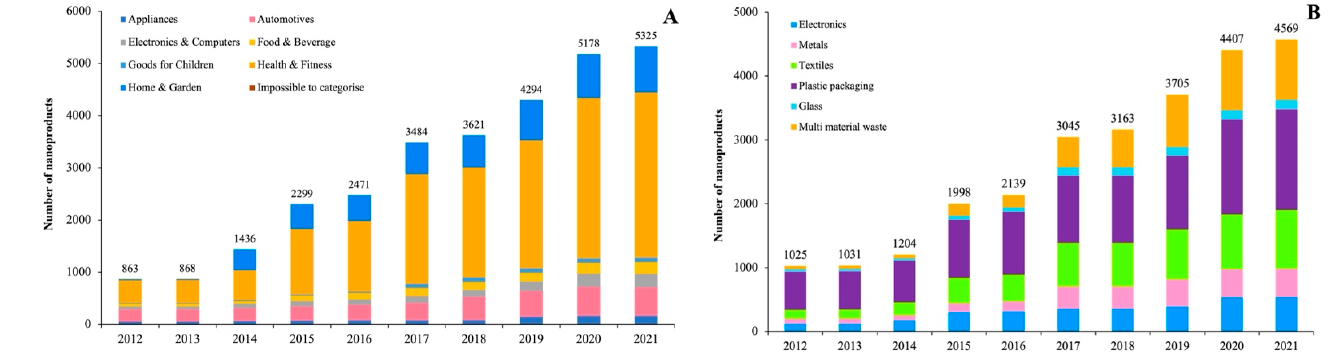
Figure 2. Overview on NTs-containing products in Europe based on latest data available from the “Nanodatabase” in June 2021 (Copyright Danish Consumer Council, Copenhagen, Denmark, 2012). ( A ) Number of nanoproducts produced during 2012 and 2021 of seven different categories. ( B ) Number of nanoproducts in the section of waste materials. Reproduced with permission of Hansen et al. [21].